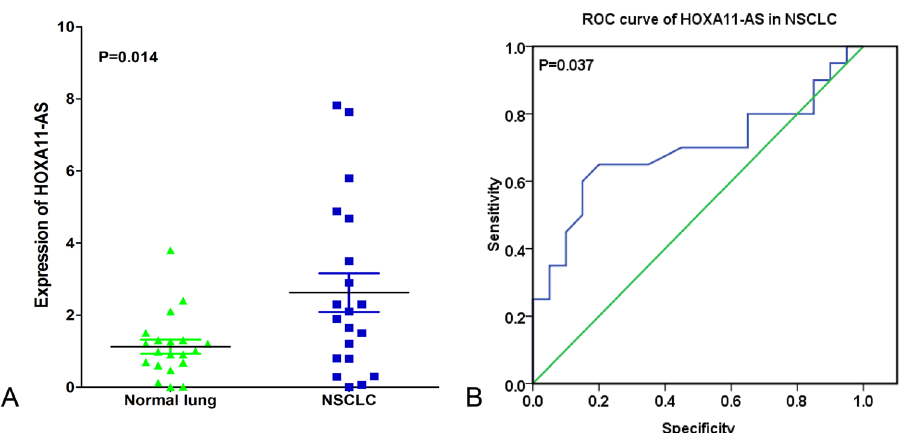
Figure 2. Differential expression and ROC curve of HOXA11-AS in NSCLC based on qRT-PCR. ( A ) Differential expression of HOXA11-AS in NSCLC. ( B ) ROC curve of HOXA11-AS in